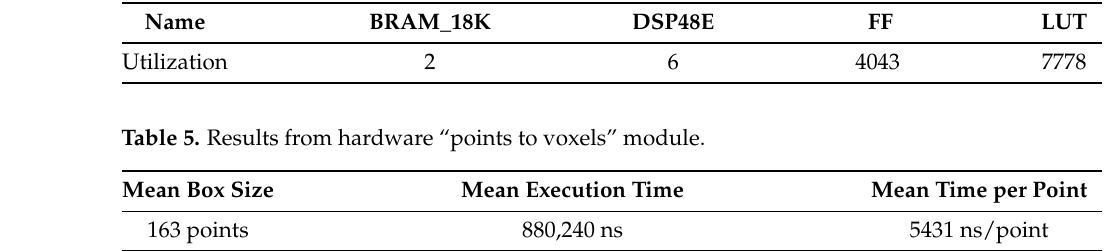
Table 4. Hardware “points to voxels” resources utilization.